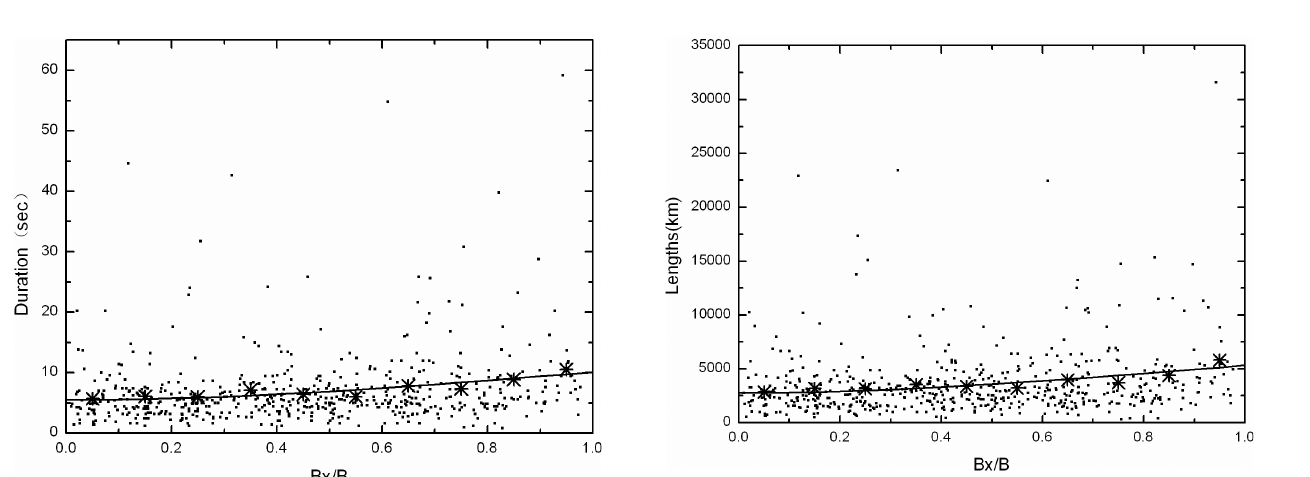
(cid:12) (cid:14) B (cid:12) (cid:12) B x (cid:12) , the ordinate is the scale of